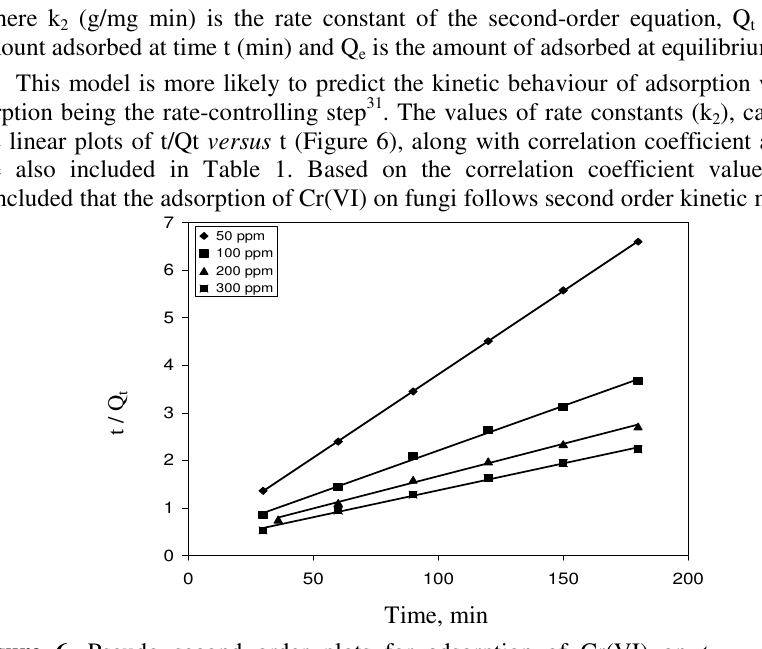
Figure 6 . Pseudo second order plots for adsorption of Cr(VI) on trametes versicolor polyporous